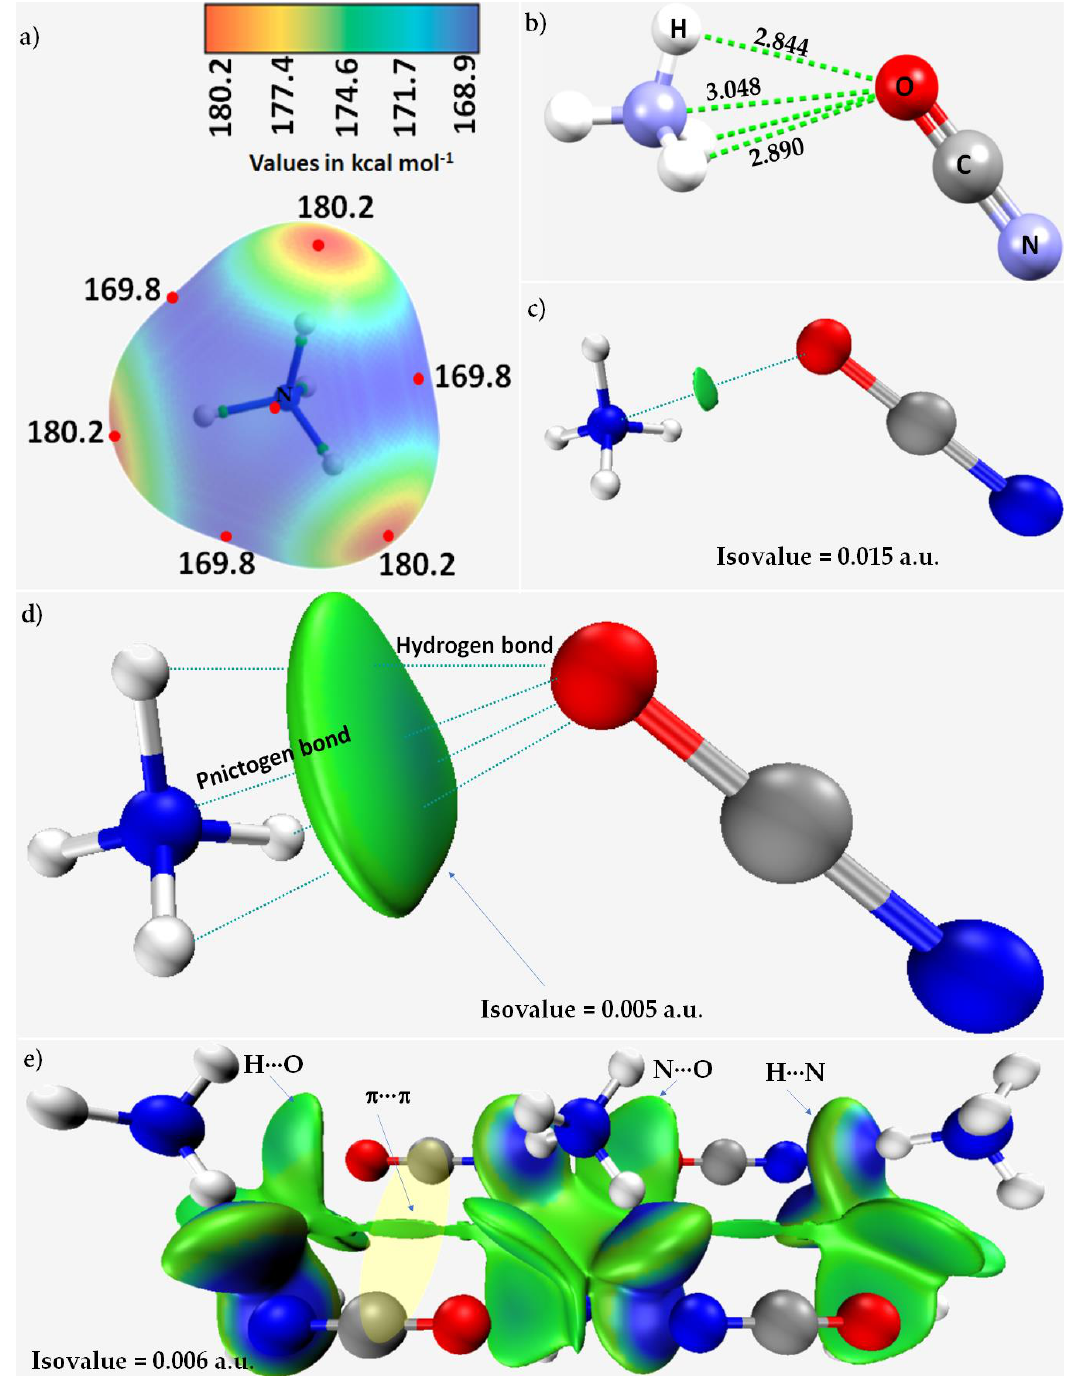
Figure 8. ( a ) The 0.001 a.u. isoelectron density mapped potential on the electrostatic surface of the NH 4+ cation, obtained using MP2/Aug-cc-pVTZ; the tiny circles in red represent the local most maxima of electrostatic potential, V S , max . ( b ) The local nature of N – H···O hydrogen bonding and H – N···O pnictogen bonding interactions between the NH 4+ and CNO − ions in NH 4 CNO. ( c , d ) IGM- δ g based isosurface volumes (colored bluish-green) between NH 4+ and CNO − ions, with two different isovalues of IGM. ( e ) IGM- δ g based isosurface volume (colored bluish-green) between NH 4+ and CNO − ions as in a 2 × 2 × 2 supercell structure of the system, showing different interaction types between the interacting moieties. Bond distances and bond angles are in Å and degrees, respectively. Intermolecular contacts in ( b – d ) are colored in cyan/green.